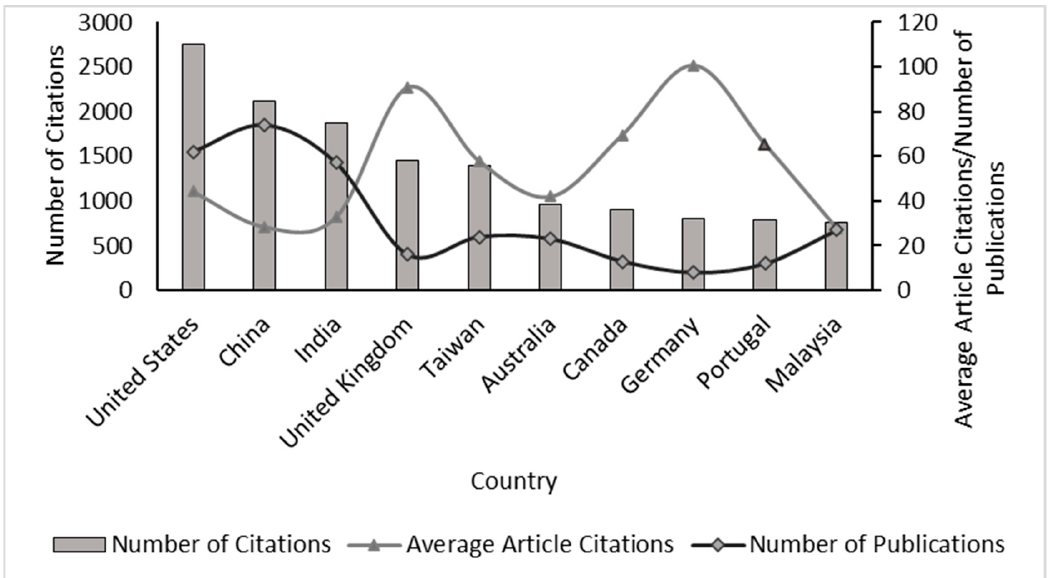
Figure 1. Leading countries in publications on CO 2 capture with microalgae, data-based Scopus re- ports.